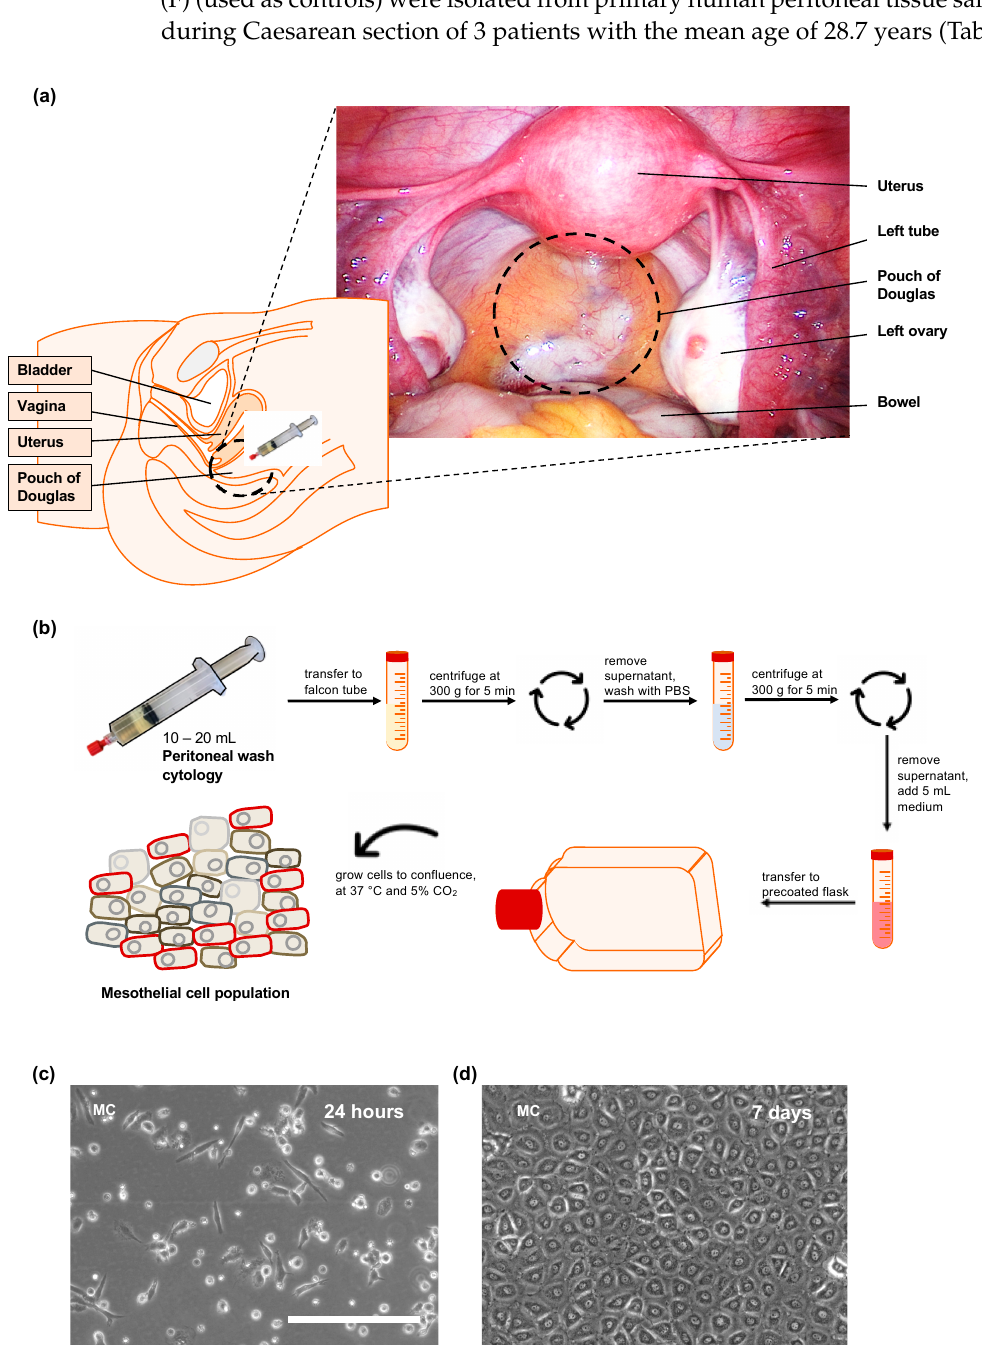
Figure 1. Isolation methodology of PWC-derived mesothelial cells. ( a ) Intraoperative laparoscopic view and schematic illustration of the pelvic anatomy. ( b ) Overview of the protocol for the isolation and cultivation of primary human peritoneal wash cytology-derived mesothelial cells prior to additional analysis. ( c , d ) Representative brightfield images of cultured primary human PWC-derived mesothelial cells after 24 h ( c ) and 7 days ( d ). Scale bar represents 200 µm for both images.